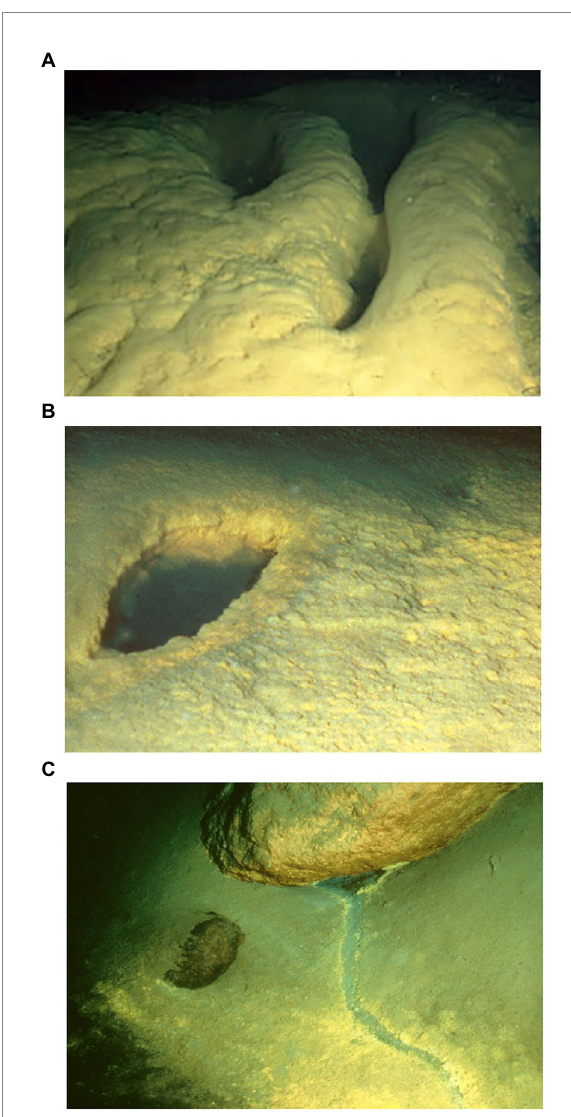
FIGURE 2 Representative photos of bacterial mat collection sites: (A) “Brain mat” bacterial growth west of Llao’s Bath within the Llao’s Bath/ Brain Mat complex; (B) Llao’s Bath brine pool with surrounding bacterial mat; (C) A rill within the Palisades Point area. This channel or rill flows downhill from its origin under the boulder (upper part of the photo). Each photo field of view is approximately three meters across. Images courtesy of Collier et al., 1991.